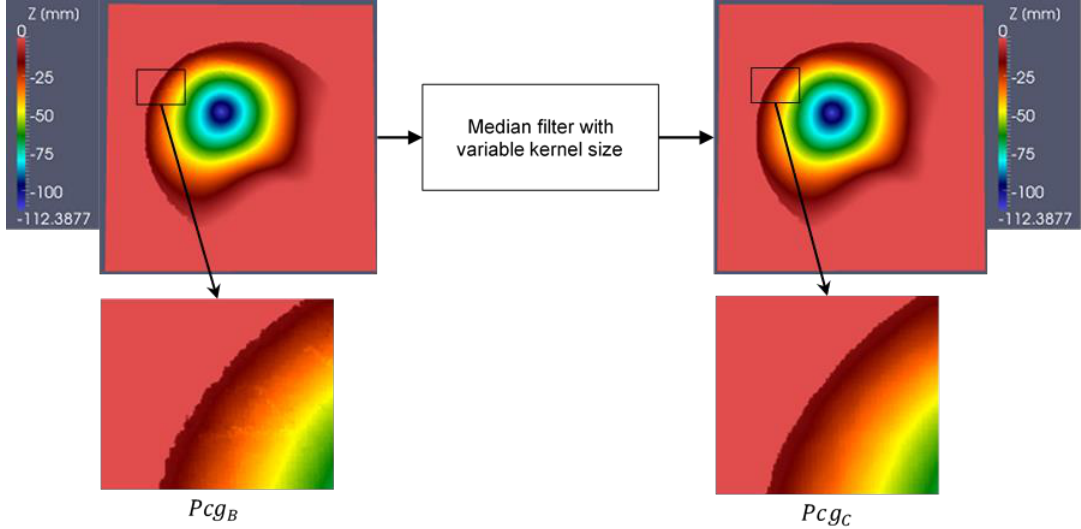
Figure A10. Result of the median filter with variable kernel size (the intensity of the images corresponds to the z coordinate of the corresponding pixels). Illustration for Patient002.